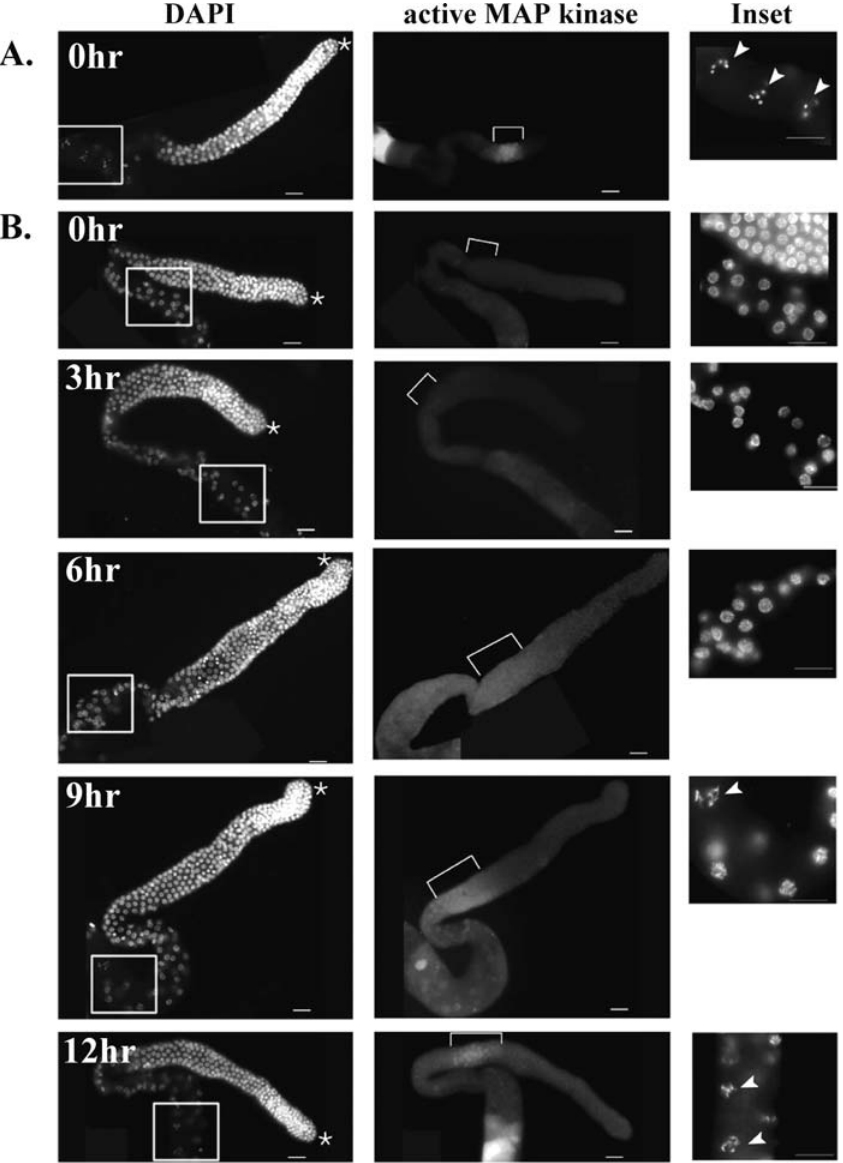
Figure 1. Meiotic Progression and MAP Kinase Activation Is Restored after Shift to Permissive Temperature Dissected gonads were stained with DAPI (left column) and a -diP MAP kinase (middle column). Boxed area in left column is enlarged in right column (inset) to show germ cell morphology during meiotic progression. Asterisks indicate distal end of germ line. Arrowheads indicate nuclei in diakinesis. Brackets indicate region with activated MAP kinase staining. (A) Gonads from control animals. (B) mpk-1 gonads at 26 8 C (0 h) and following shift to 15 8 C (3–12 h). All gonads also carry fem-1(hc17) and unc-79(e1068) alleles. Scale bar, 20 l